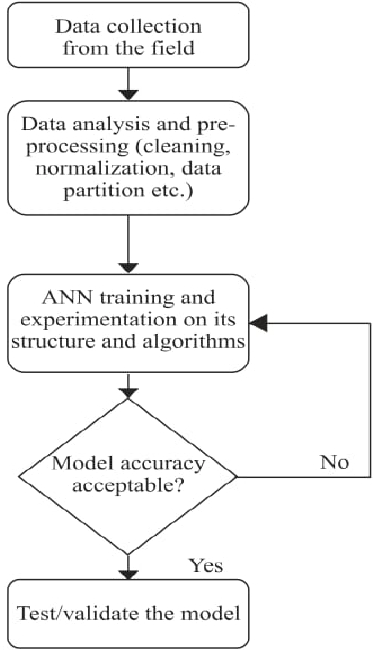
Figure 3. Flowchart of the ANN-based model building process.